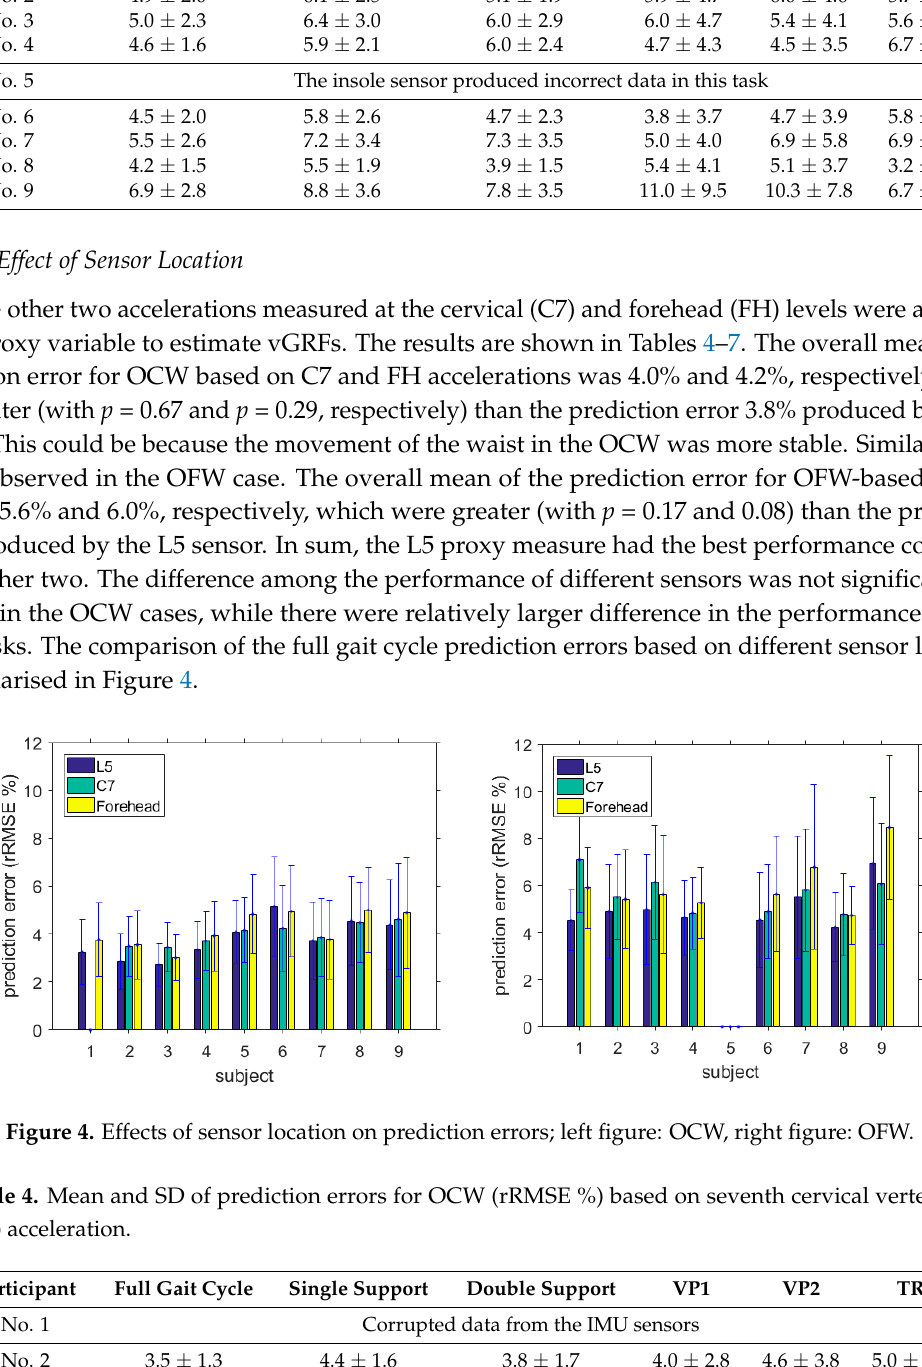
Table 3. Mean and SD of prediction errors for OFW (rRMSE %) based on L5 acceleration.